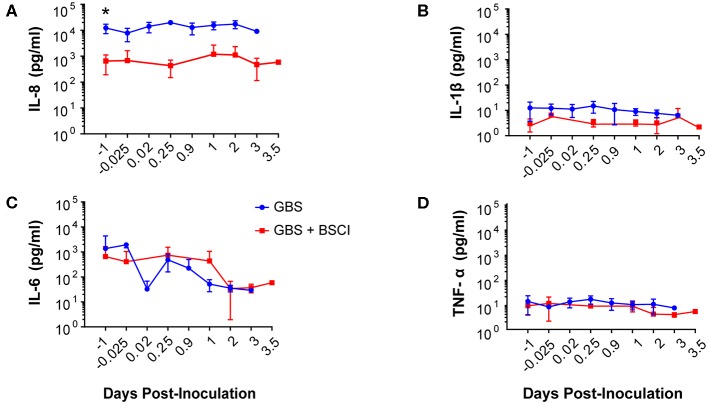
In maternal plasma, BSCI treatment was associated with lower IL-8 (A) and IL-1β (B) levels at most time points compared to the GBS group, but this was only significant prior to experimental start for IL-8. IL-6 (C) and TNF-α levels (D) in the maternal plasma of the BSCI and GBS groups were not significantly different by Wilcoxon rank sum. *p < 0.05.